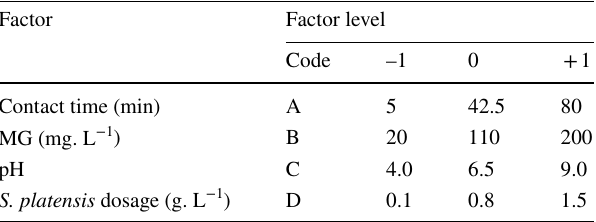
Table 1 Range and levels of independent factors used for the MG biosorption